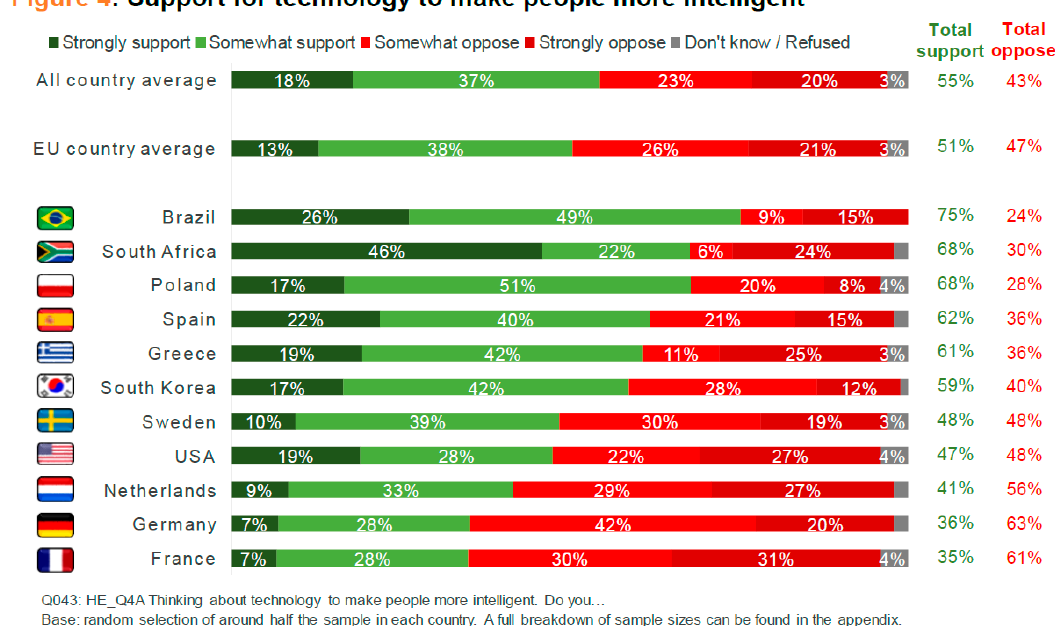
Scheme 3. “Acceptability of conducting laboratory experiments on human embryos to understand how to increase human intelligence” [23] (p.